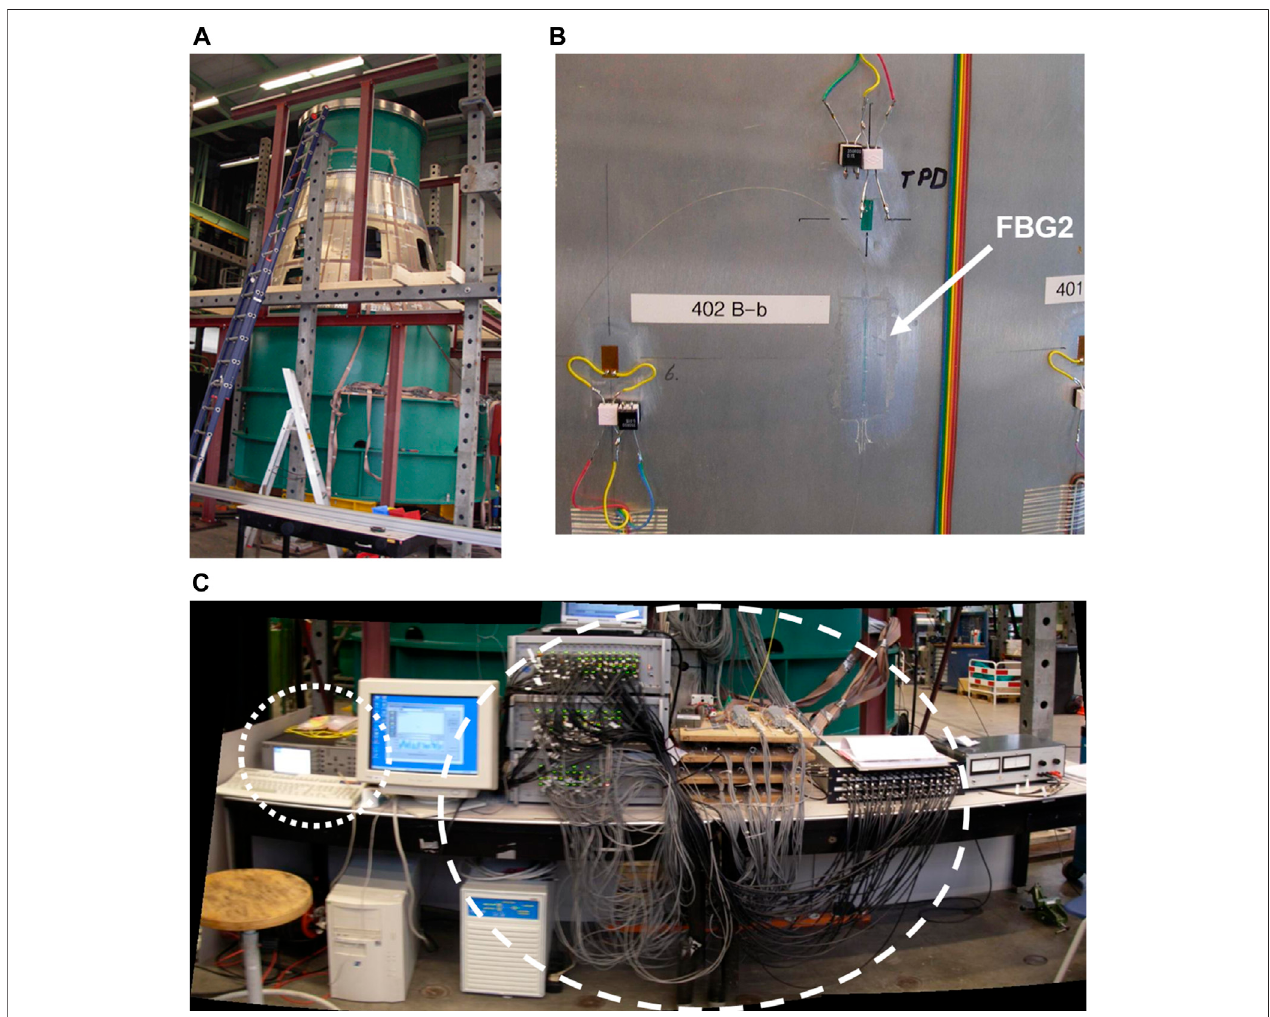
FIGURE 7 | (A) Vega Interstage 1/2 installed on test bench, (B) Conventional strain gauge “ TPD ” and surface mounted “ FBG2 ” located on the same vertical plane on the Vega Interstage 1/2 to measure the strain during compression load, (C) Comparison between the FBG interrogator MO SI425 (dotted line) and the conventional system for 40 electrical strain gauges (dashed